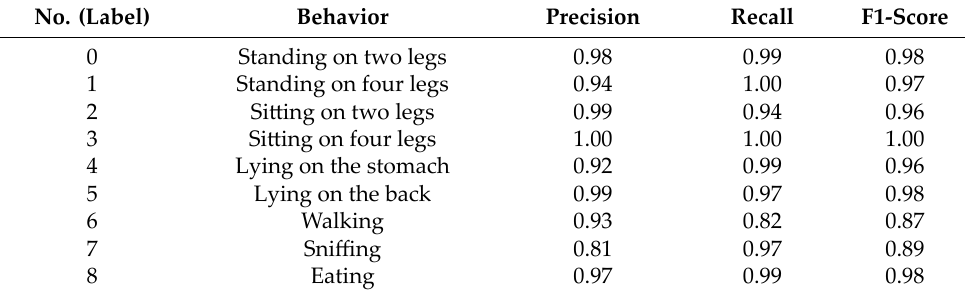
Table 7. Behavioral prediction model of the training